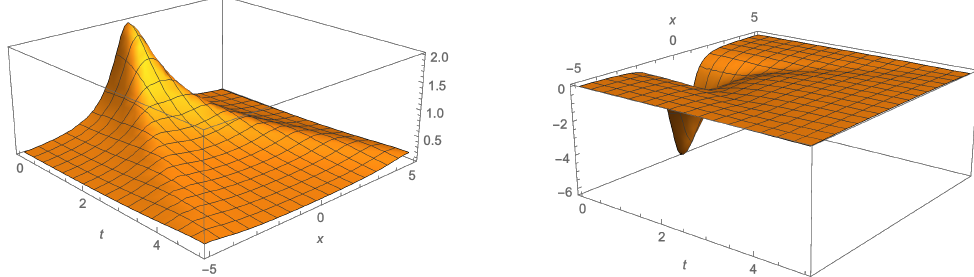
(left) and ˜ β (right) as a function of ( t, x ) . Here we set Figure 7 : The quantities ˜ α H H = 1 and we use the relations in eq. (2.19), valid for small A = 1 , α H